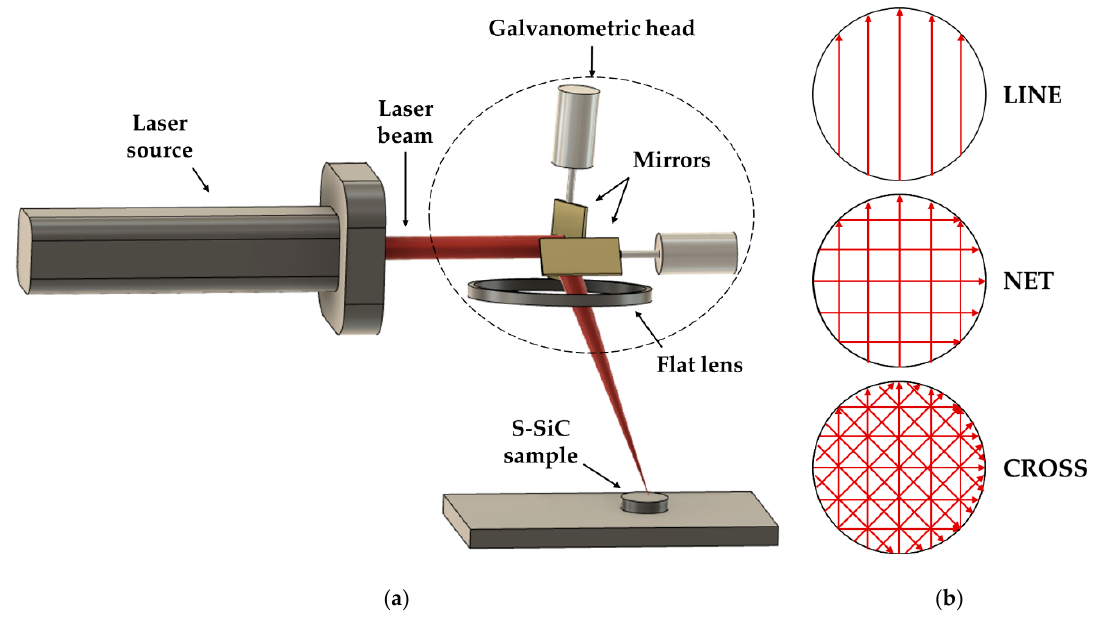
Figure 2. ( a ) Schematic of the system used for sample laser-treatments. ( b ) Preliminary tests were used to evaluate the best scanning strategy: LINE, NET, and CROSS.